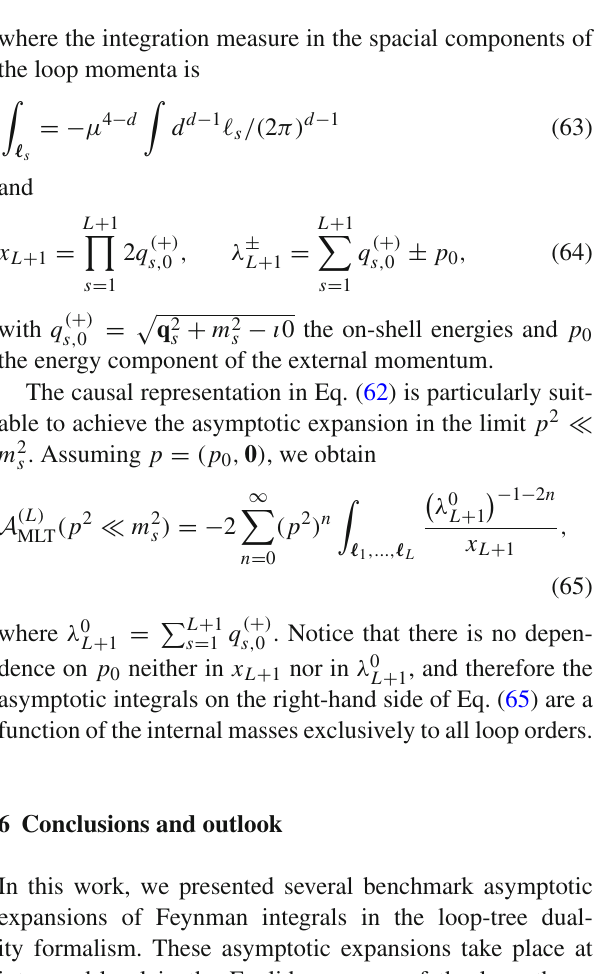
Fig. 6 Maximal Loop Topology at L loops with arbitrary internal